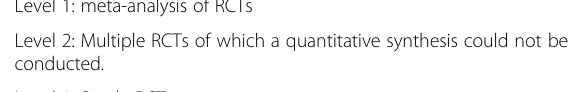
Category A: randomized controlled trials reporting comparative results for specific outcomes between different interventions. Level 1: meta-analysis of RCTs Level 2: Multiple RCTs of which a quantitative synthesis could not be